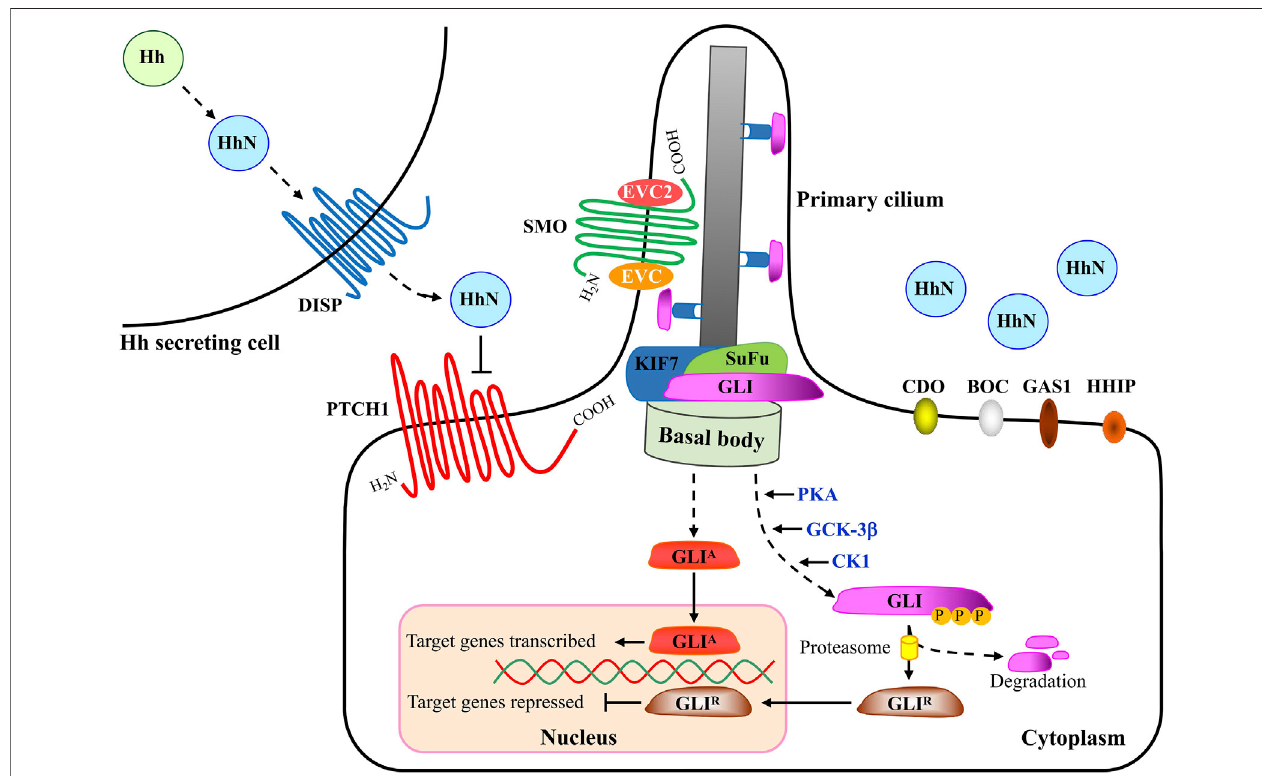
FIGURE2| AschematicdescriptionofHedgehogsignalingtransduction.WhenHHisabsent,the12-span-membranereceptorproteinPTCH1(Patched1)inhibits SMO (Smoothened) accumulation in the primary cilium and consequently SMO activity. SuFu can form complexes with GLI proteins and inhibit them from entering the nucleus and their transcriptional activity. Several kinases, including PKA, GSK3 β and CK1 phosphorylate the C-terminal of GLIs, leading to the truncated form of full lengthGLI.C-terminaldeleted-GLIsarethought tobestrong transcriptional repressors(GLI-R)thatgointothenucleusand inhibitthetranscription oftargetgenes. Upon HH ligand binding, the inhibition from PTCH1 is released and SMO is activated and translocates into the primary cilium. Within the primary cilium, SMO forms a complexwithEVCandEVC2totransducetheHHsignalingresponse.ActivatedSMOleadstothereleaseofGLIsfromtheSuFucomplexandGLIsgointothenucleusas transcriptional activators (GLI-A) that activate the transcription of target genes. Movement of GLI proteins within the primary cilium occurs in conjunction with KIF7, a memberofthekinesinfamilyofanterogrademotorproteins.Abbreviations:HH,Hedgehog;DISP,Dispatched;PTCH1,Patched1;CDO,Celladhesionmolecule-related/ down-regulated by oncogenes; BOC, brother of Cdo/biregional Cdon-binding protein; Gas1, Growth arrest speci fi c 1; HHIP, Hedgehog-interacting protein; SMO, Smoothened; EVC, Ellis van Creveld syndrome protein; EVC2, Ellis van Creveld syndrome protein 2; GLI, Glioma-associated oncogene; SuFu, Suppressor of Fused; KIF7, Kinesin family member